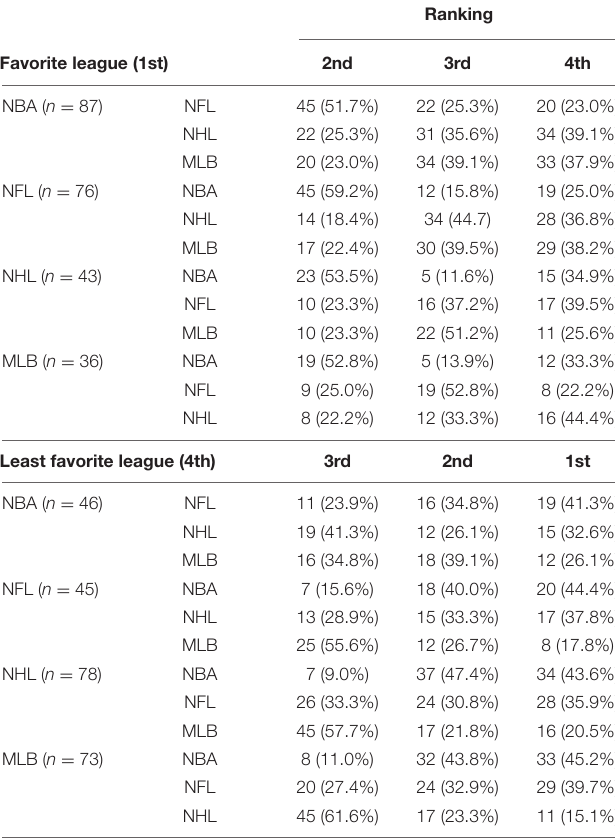
TABLE 2 | Rankings for favorite and least favorite league.